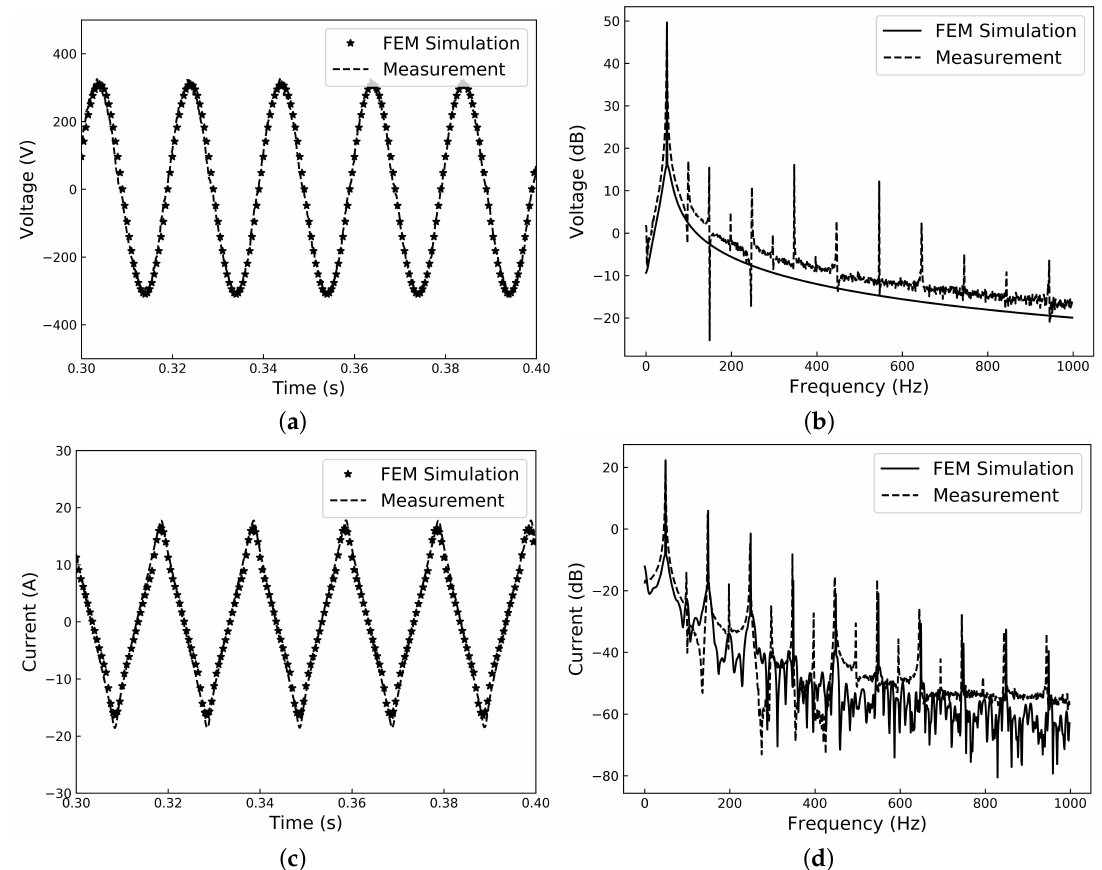
Figure 10. Comparison between the FEM and experimental result in ( a ) voltage; ( b ) voltage spectrum; ( c ) current; and ( d ) current spectrum on the single phase transformer.